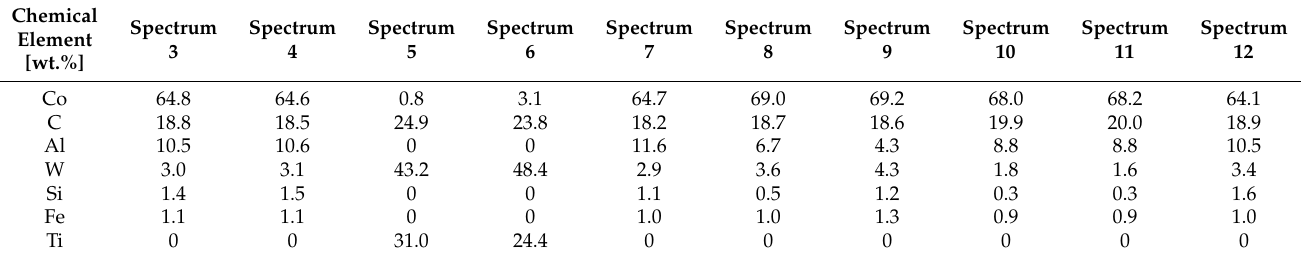
Table 2. EDS point analysis of Co70W12Al15 alloy.